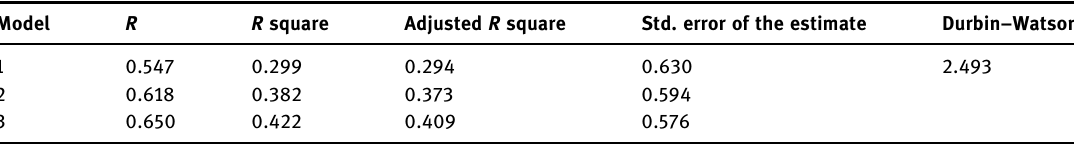
Table 3: Goodness - of - fi t test of brand preferences and brand image dimensions Model